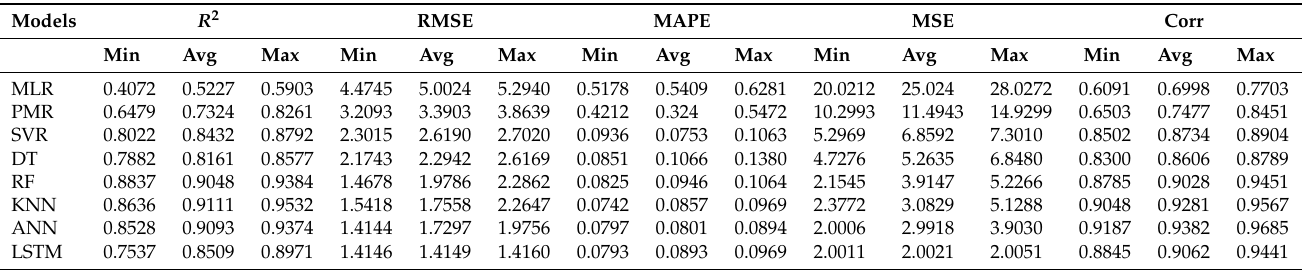
Figure 9. Training and validation loss for both ANN and RNN models. Table 3. Performance metrics after removing the antenna height from the input features of the